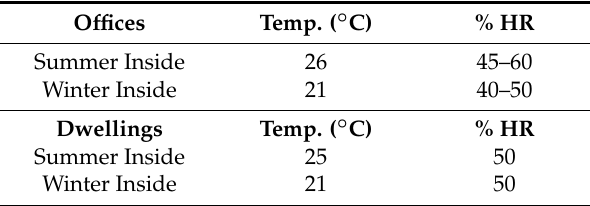
Table 1. Reference for the comfort data [33].